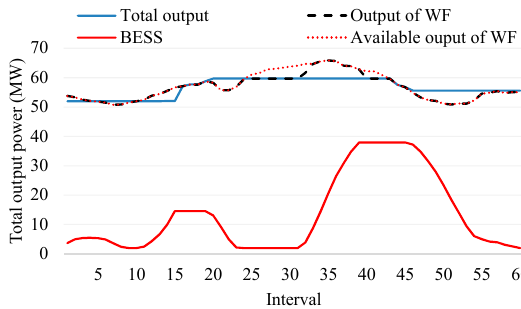
Figure 14. Optimal output power of WF.